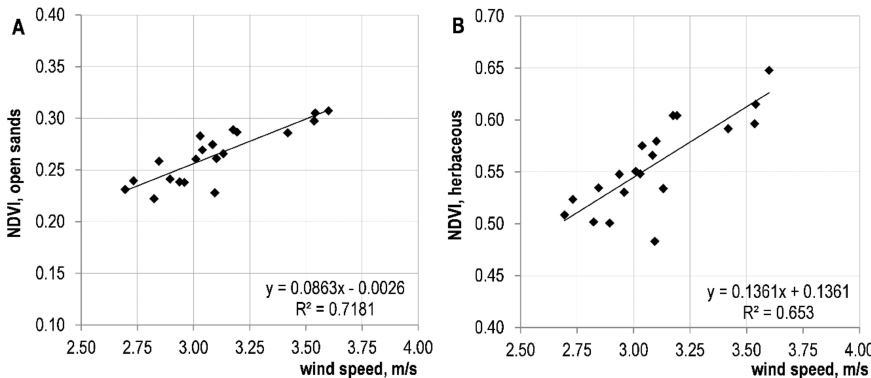
Figure 6. The relationship between average values of NDVI and wind speed in open sands ( A ) and herbaceous ( B ) ecosystems during the growing season